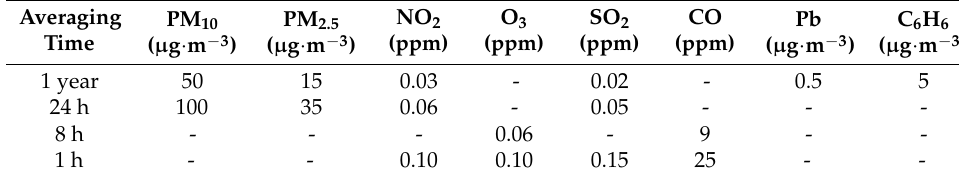
Table 2. Air quality standard for criteria pollutants in Korea